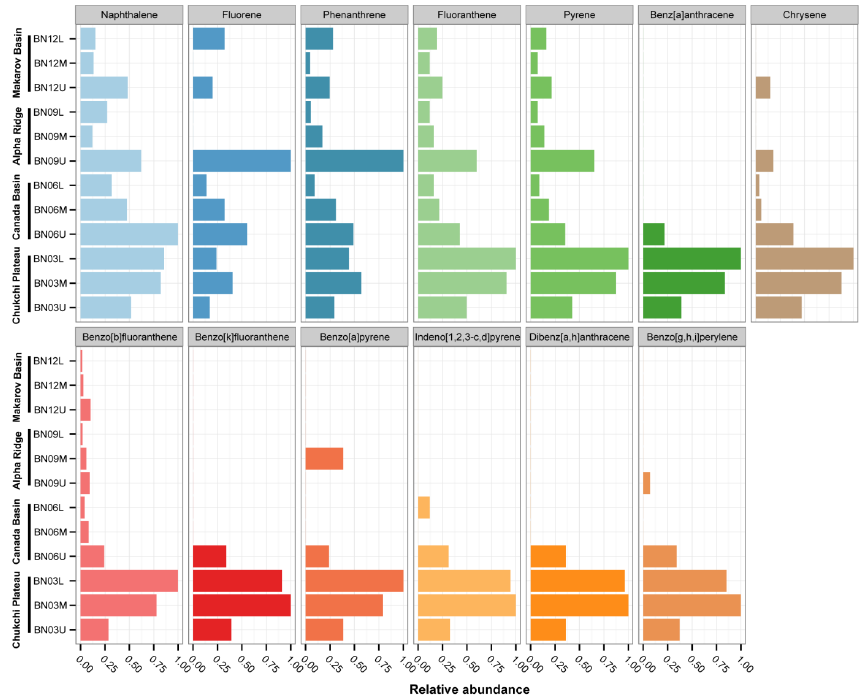
Figure 2. The distribution and relative abundance of 16 EPA-priority PAHs in the sediments of the Arctic Ocean. For each PAH, its relative abundance in all 12 samples was presented using different bar lengths in a sub-plot. The longest bar in a sub-plot indicates that this sample has the highest concentration value of a PAH in all 12 samples. The length of the other bars was proportionately shorted based on the ratios of the concentration values of other samples divided by the most abundant PAH in this sample. Acenaphthylene, acenaphthene and anthracene were not presented in this plot because their concentrations were below the detection limits in all sediment samples. U, M and L in the sample names refer to the upper, middle and lower layers of the sediments,